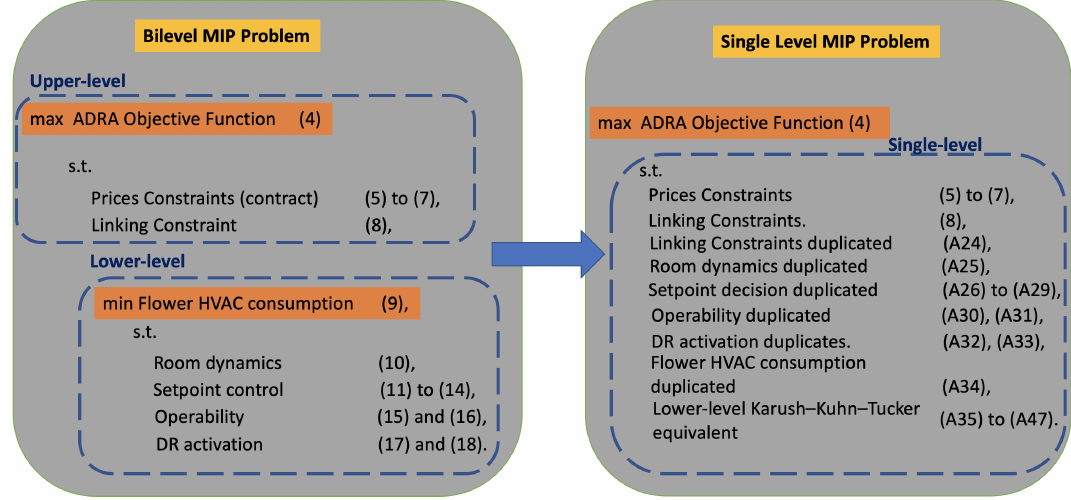
Figure 5. Bilevel MIP Problem reformulation into a Single MIP